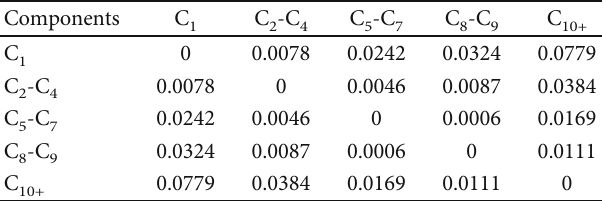
Table 4: Binary interaction parameters for oil components.